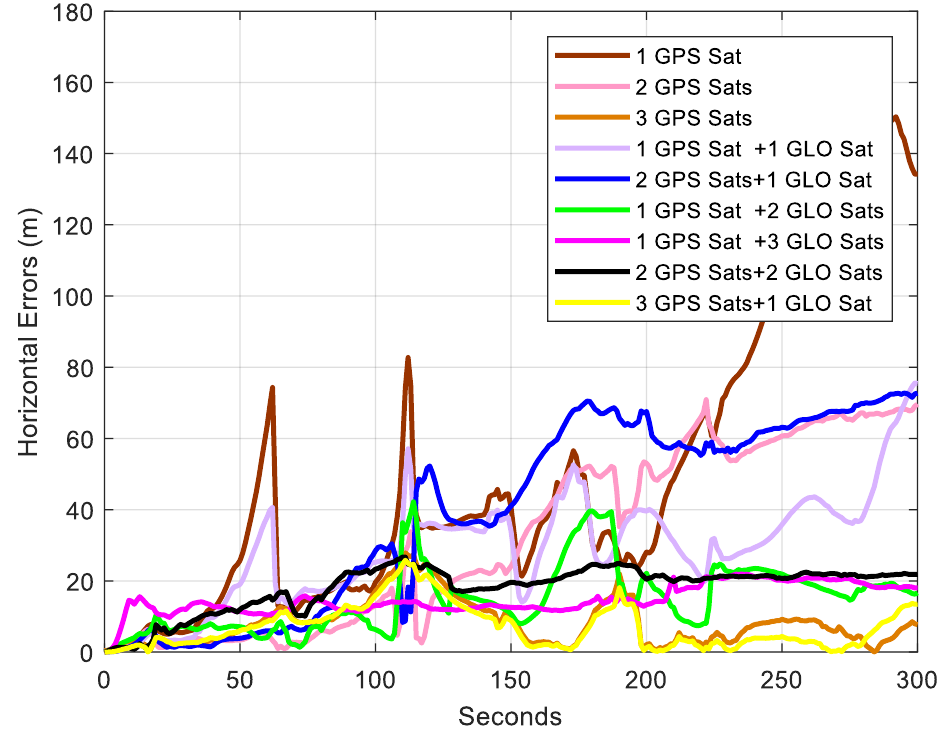
Figure 9. Horizontal errors of trajectories using different satellites. Table 1. Summary of horizontal errors using different satellites. GLO: GLONASS; sat: satellite.